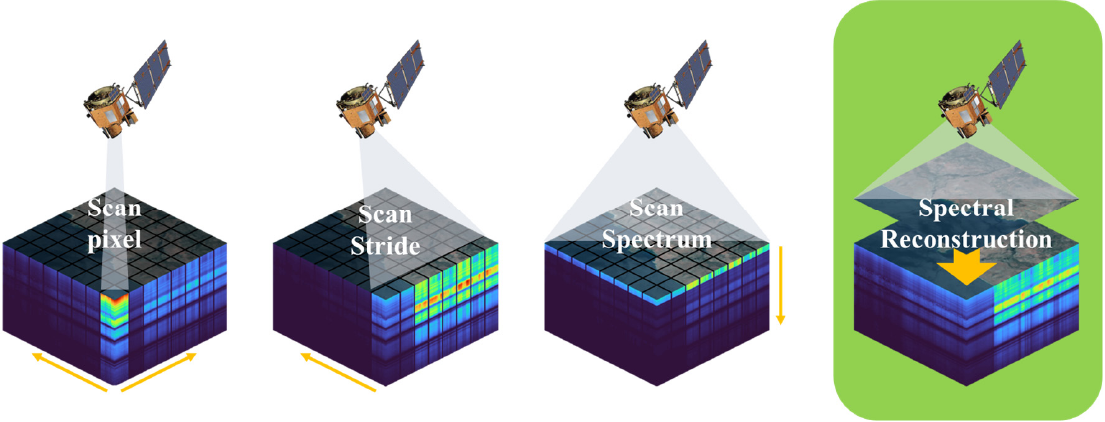
Figure 1. Comparison of sensor scan-based remote sensing hyperspectral imaging mechanisms and spectral reconstruction methods.